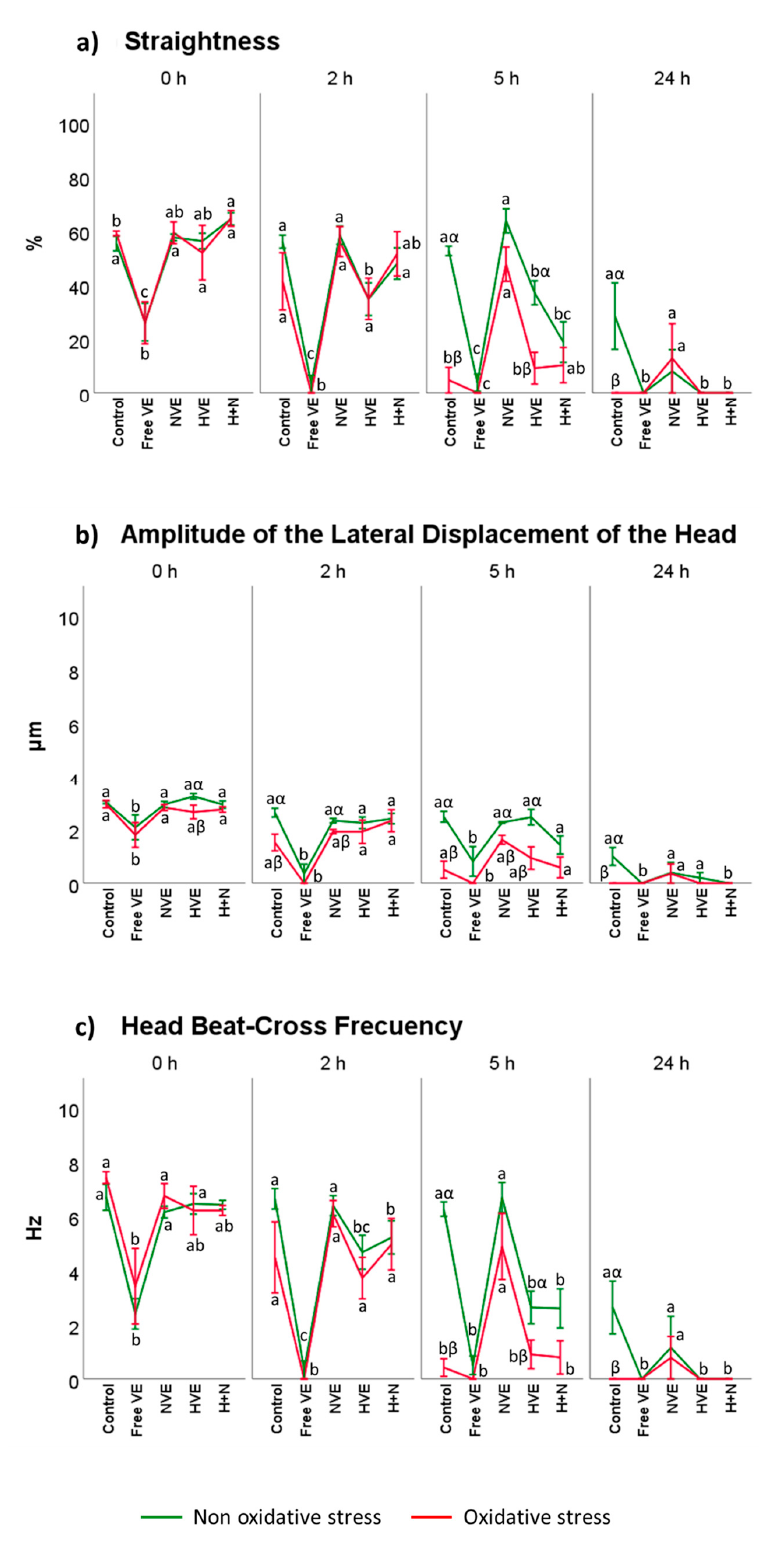
Figure 6. Vitamin E formulation effects on sperm kinematic parameters. Plots ( a – c ) represent the triple interaction of different vitamin E treatments × oxidative treatment × incubation time for CASA-derived variables. The various lowercase Latin letters ( p < 0.05) indicate significant differences between vitamin E treatments, while the different Greek letters ( p < 0.05) compare each treatment at the same time with a different oxidative stress status.